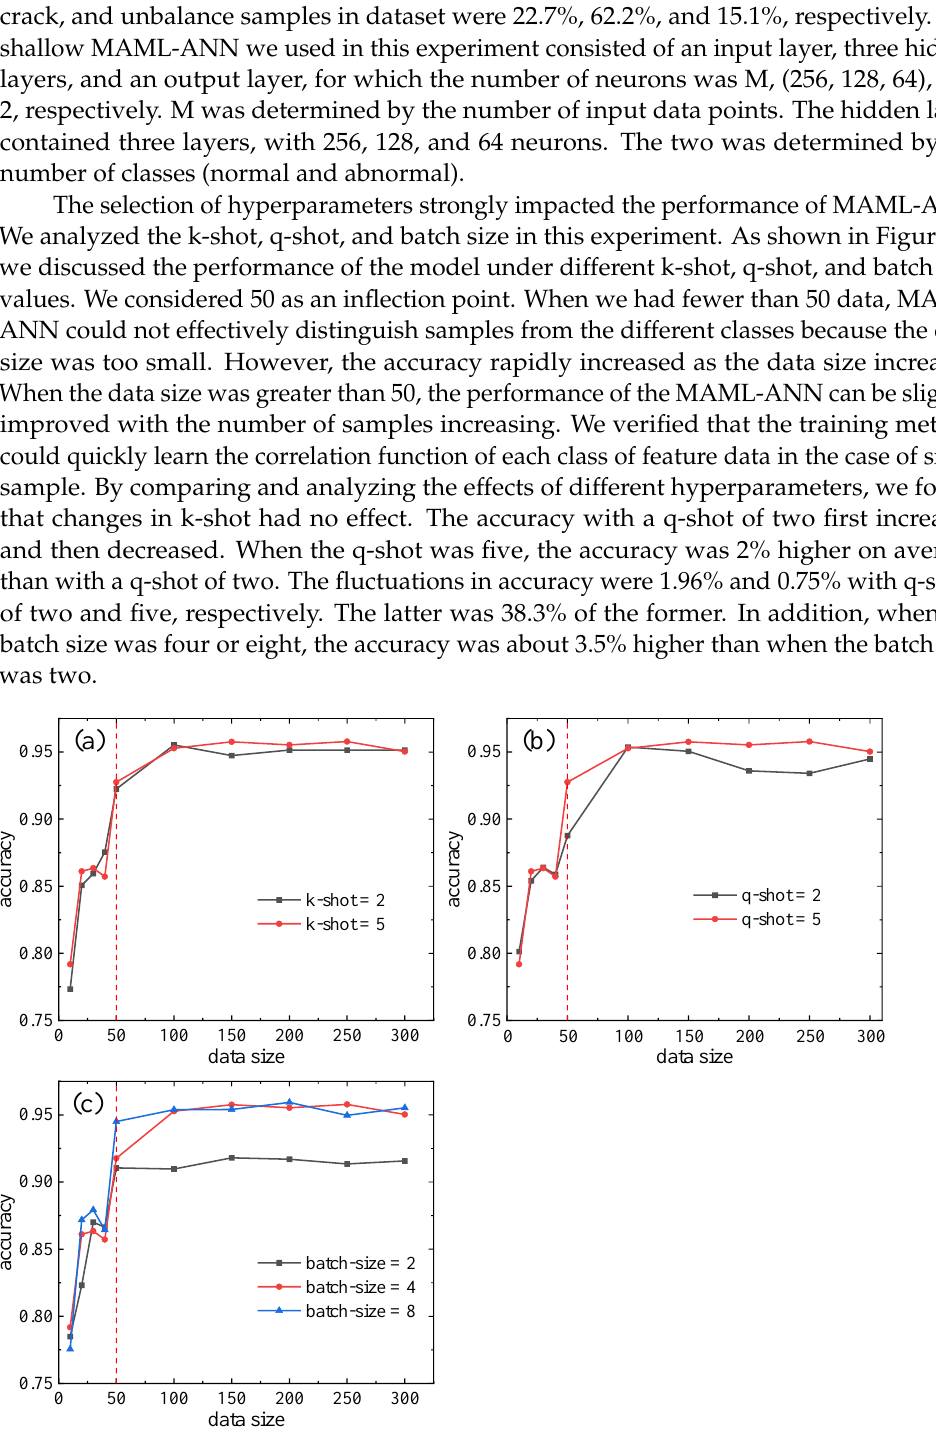
Figure 13. Comparison between accuracies for different ( a ) k-shot, ( b ) q-shot, and ( c ) batch